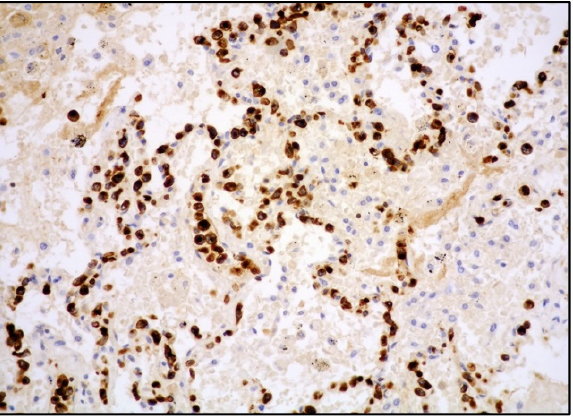
Figure 4. High-power view showing lung parenchyma with perforin-positive atypical cells within